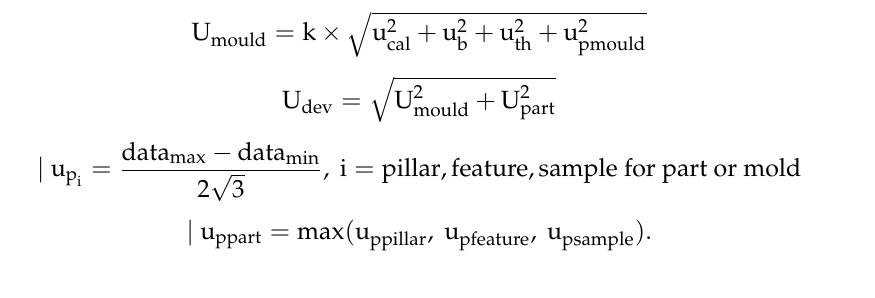
Table 3. Uncertainty contribution for pillar height measurements.